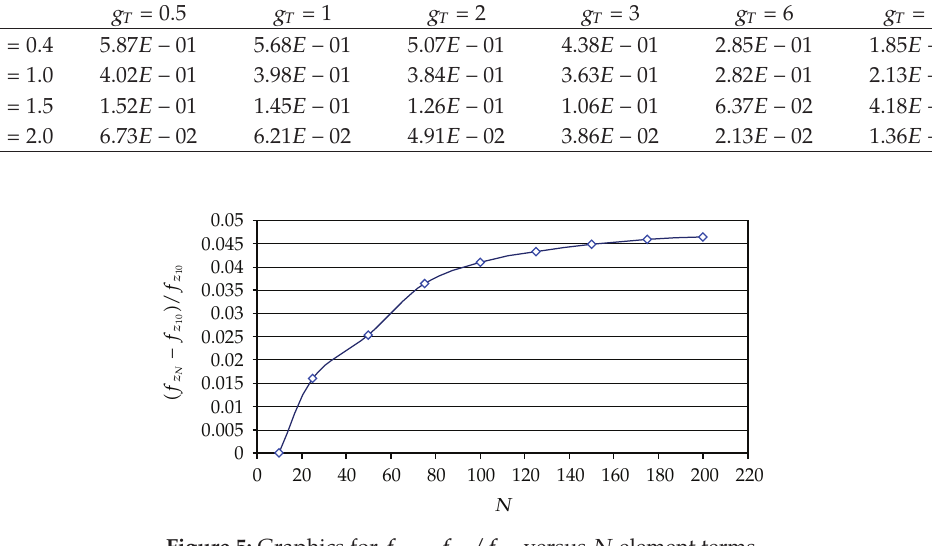
Figure 5: Graphics for f z